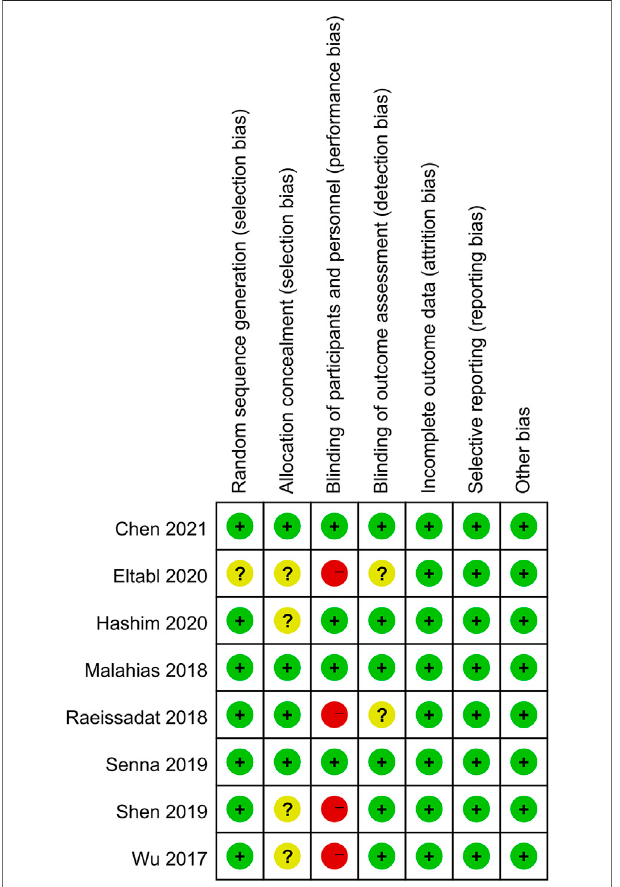
FIGURE 2 | Risk of bias graph: low risk of bias in green; unclear risk of bias in yellow; high risk of bias in red.